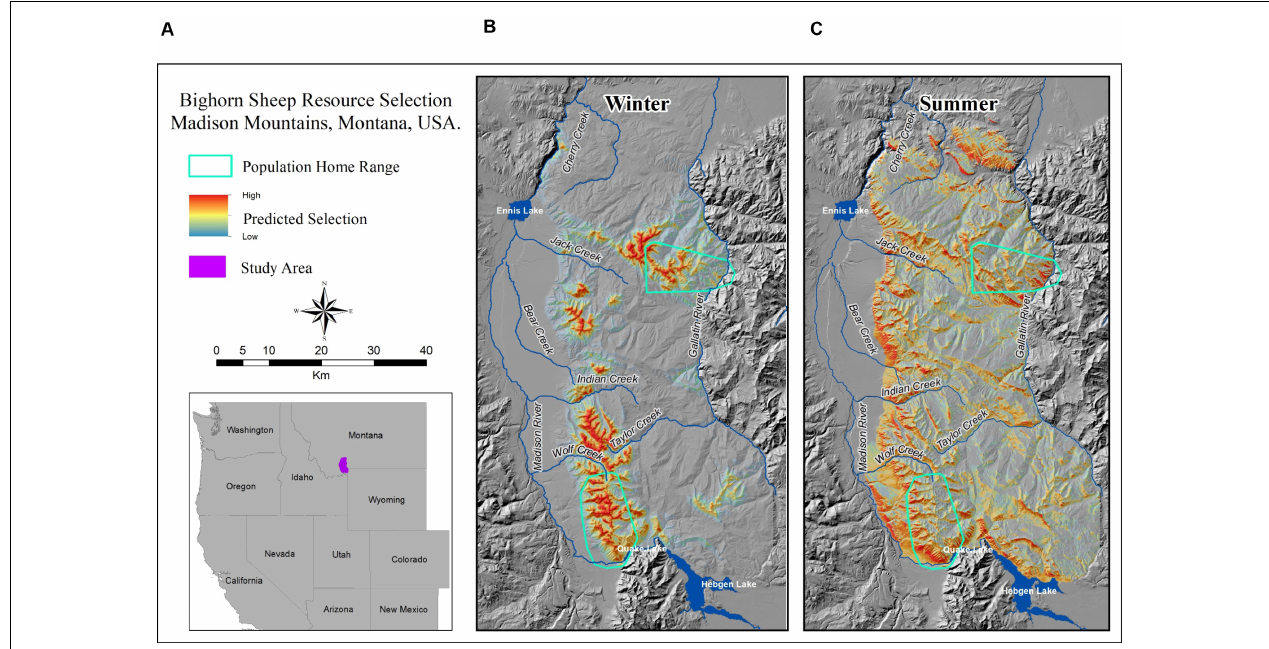
FIGURE 4 | In southwest Montana, United States (A) , predictions of bighorn sheep landscape use (B,C) from a resource selection function (RSF) were applied to an explicit inference space of historical but currently unoccupied bighorn sheep range to estimate potential winter and summer use ( B,C , from Lula et al., 2020). Cool colors depict areas of low predicted selection, and warm colors areas of high predicted selection. The RSF was developed with telemetry data and validated with estimates of population abundance from established populations in nearby areas within the same historical range (summer and winter population home ranges, B,C